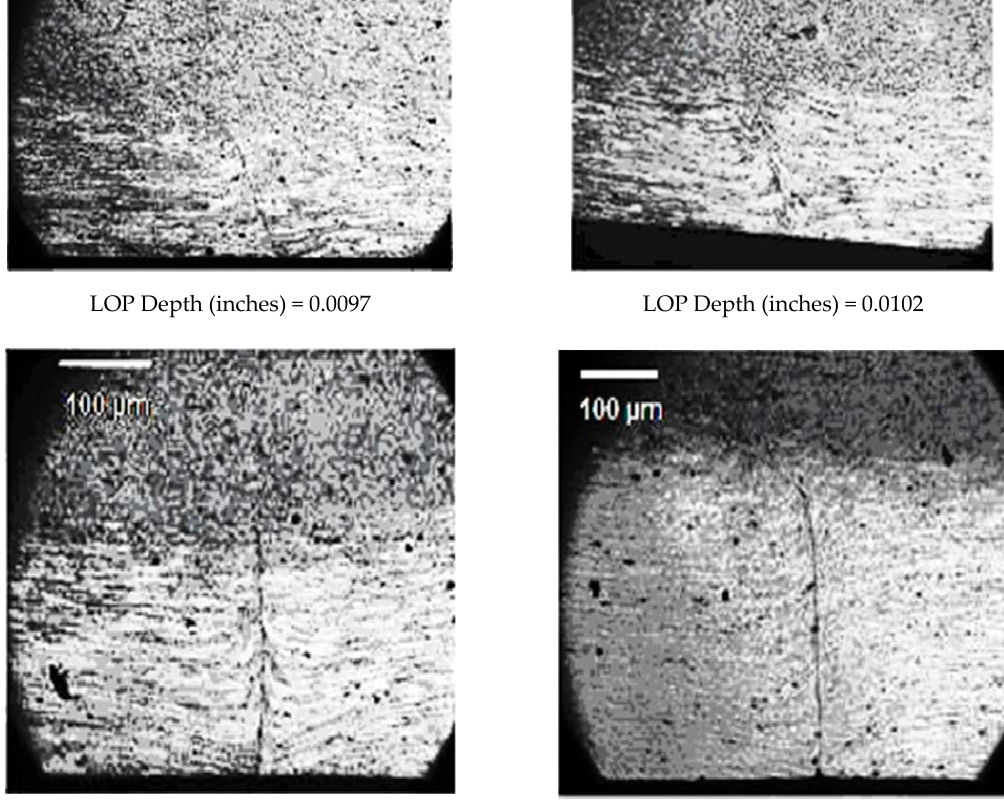
Figure 5. Metallography of lack of penetration (LOP) defects in 3.175 mm (0.125 in) thick AL 7075-T73 panels. Reproduced with permission from [69], Taylor & Francis, 2019.